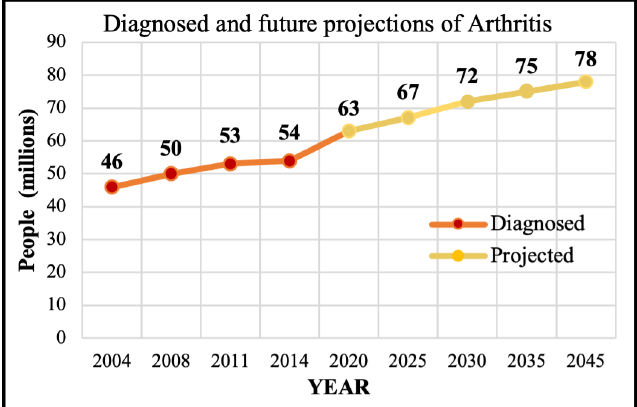
Figure 1. The diagnosed and projected Arthritis.